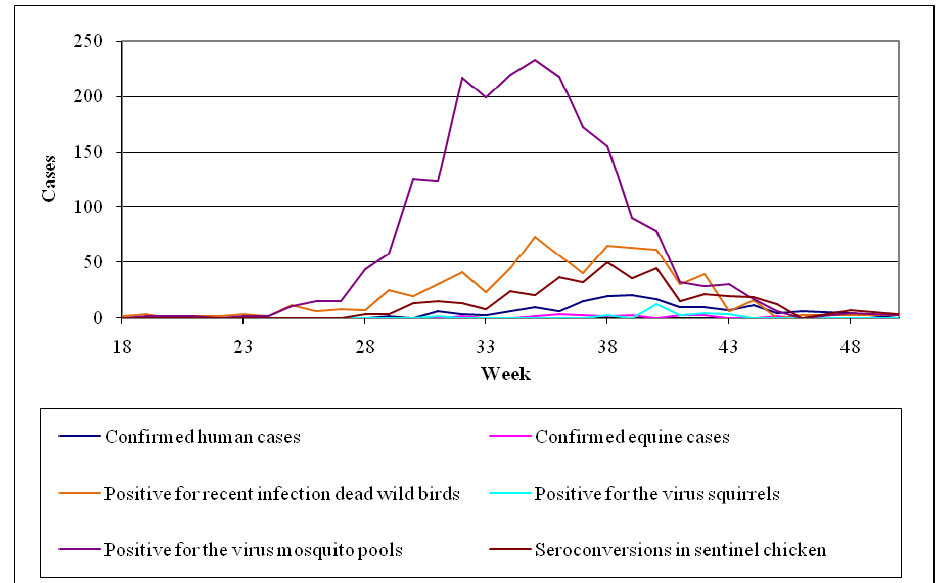
Figure 10. Weekly surveillance data from California, 2011 (data available on: http://www.westnile.ca.gov/